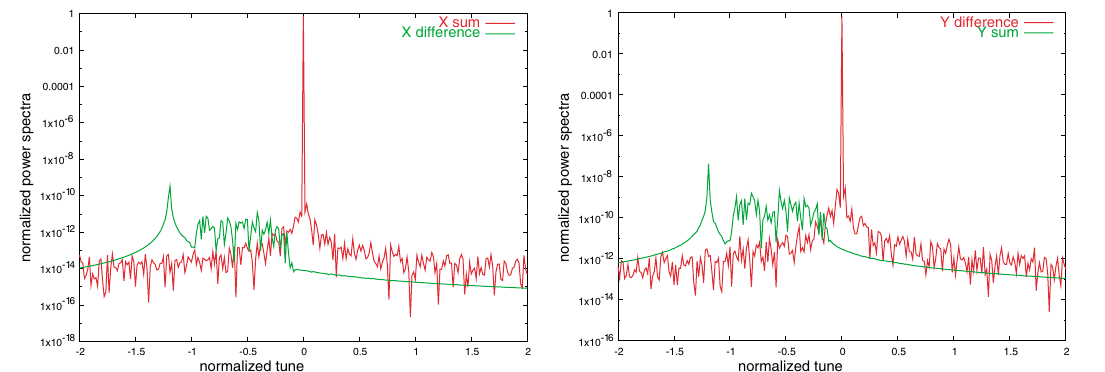
FIG. 4. (Color) Spectra of the horizontal (left panel) and vertical (right panel) sum and the difference centroid motion for nominal beam-beam collision parameters.